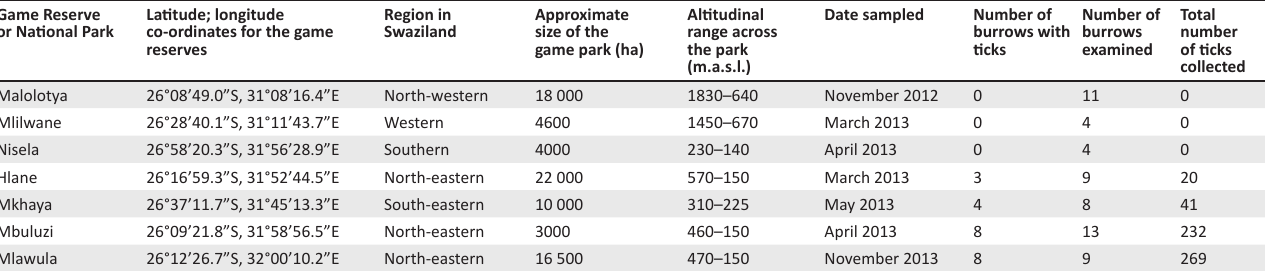
TABLE 1: Game parks and infestation rates of warthog burrows with Ornithodoros ticks in Swaziland. Game Reserve or National Park